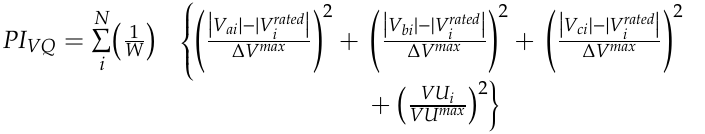
Source Converter Source Converter (VSC).